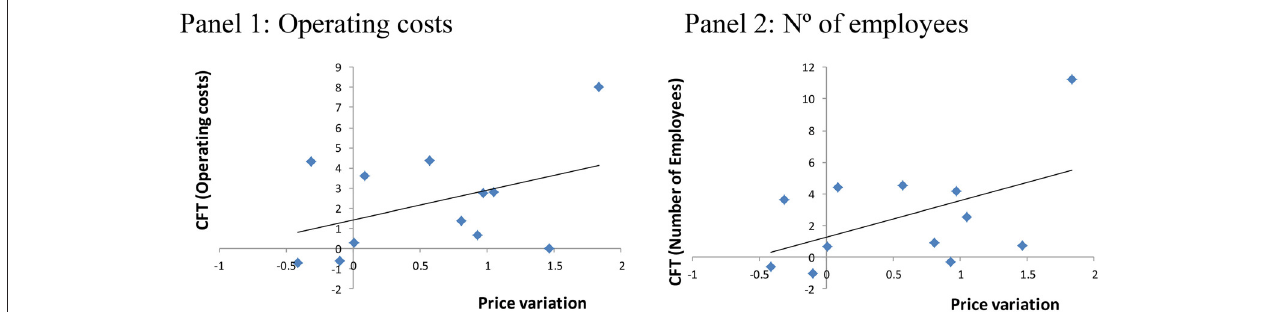
FIGURE 1 | Relationship between FT capability and variation in stock prices at the sector level.